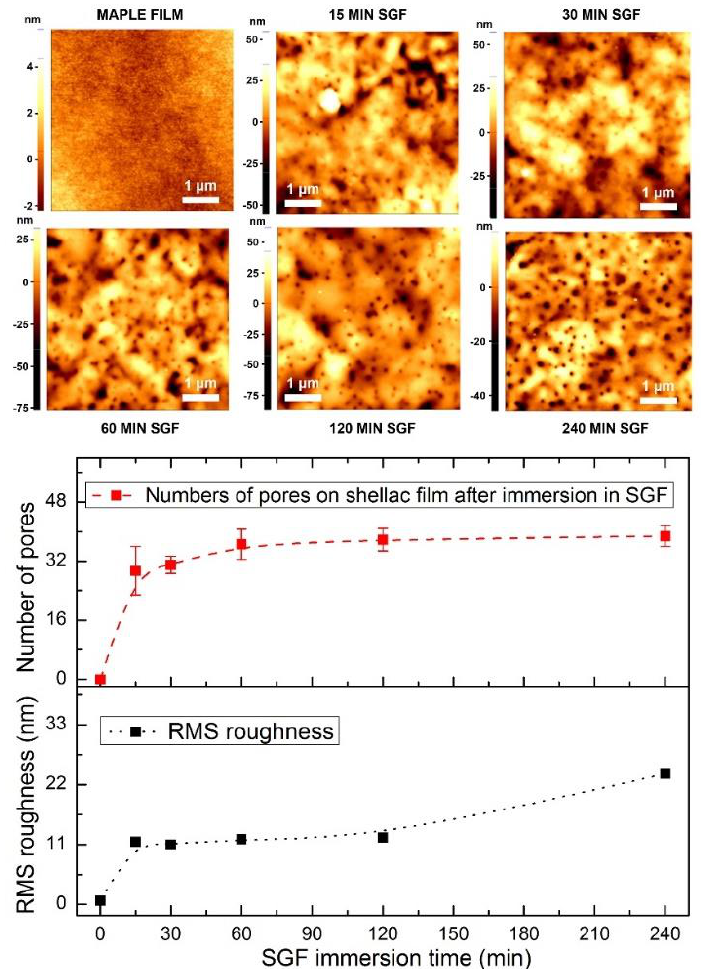
Figure 8. AFM images on 5 × 5 µ m 2 films of MAPLE shellac films immersed in SGF for different time durations. RMS Roughness on 5 × 5 µ m 2 and number of pores counted on 5 µ m 2 . The MAPLE films have a thickness of 2000 nm and were deposited using 2% shellac dissolved in methanol with a fluence of 0.6 J/cm 2 and 72,000 pulses.